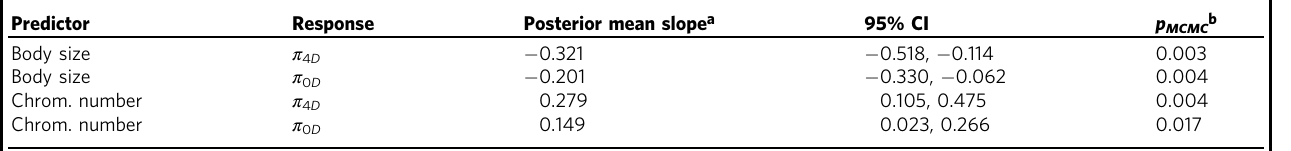
Table 1 Correlates of genetic diversity inferred under a minimal model Predictor